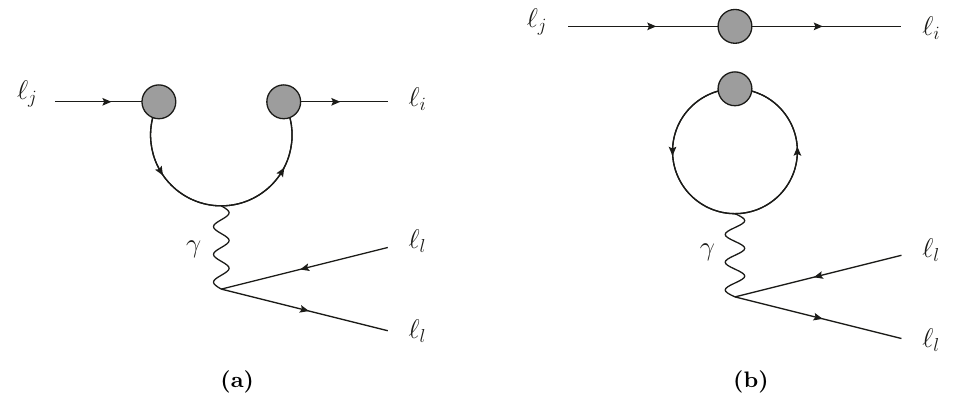
Figure 13. Feynman diagrams with two operator insertions corresponding to different Wick contractions in the EFT where the Z 0 is integrated